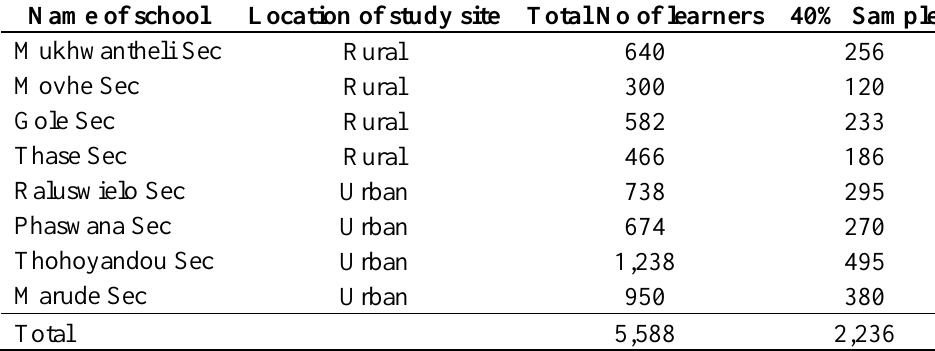
Table 1. Sample size and